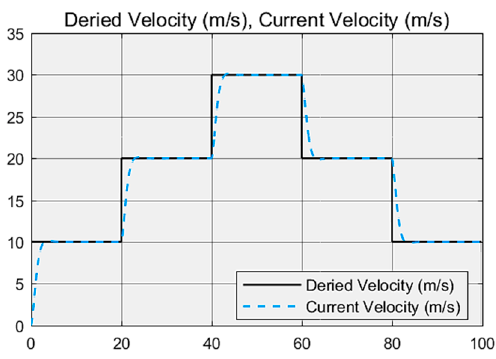
Figure 5. Simulation of the proposed longitudinal proportional-derivative (PD) control.